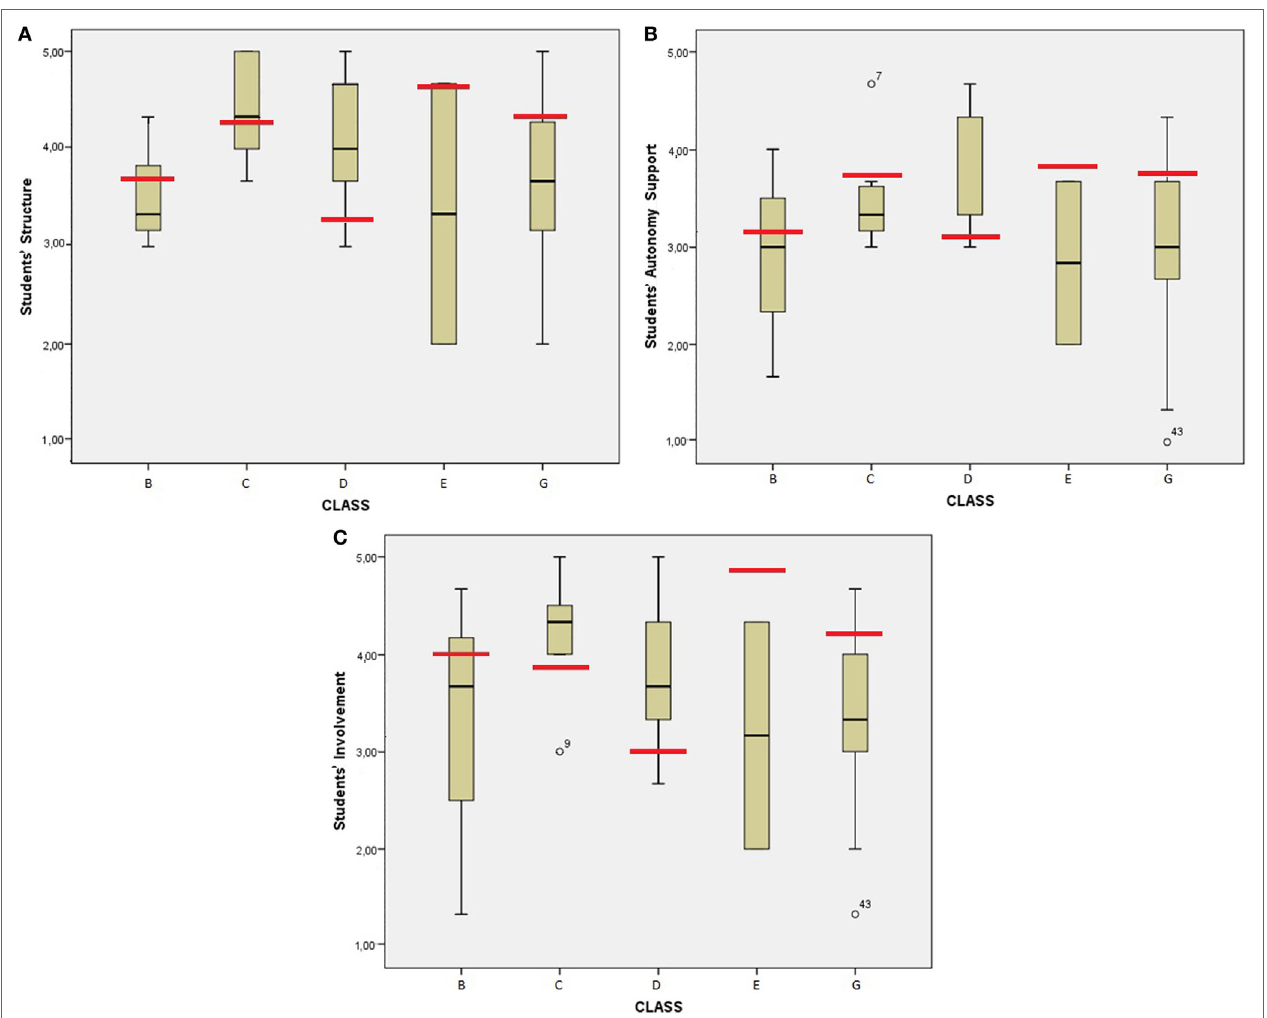
FigUre 3 | Teacher-provided and student-perceived (a) structure, (b) autonomy support, and (c)